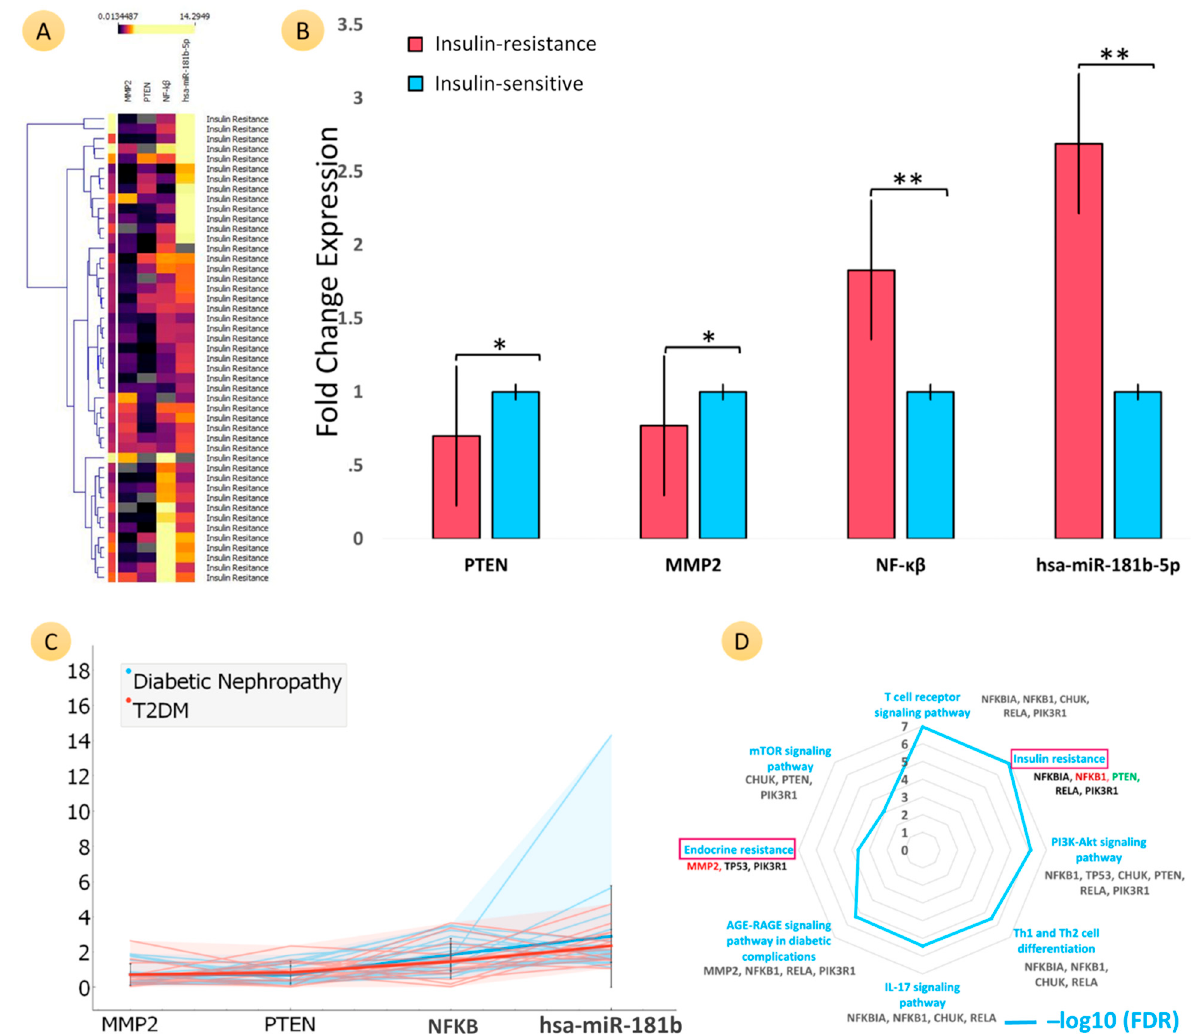
Figure 3. Comparative analyses of the mRNA expression of three genes (PTEN, MMP2, and NF- ĸ B) and microRNA-181b-5p for two groups: insulin-sensitive (IS) (control group) and insulin resistance (IR) (case group). The classification criteria of the samples were based on HOMA-IR values (IS: ≤ 2.5; IR: >2.5). Heat map ( A ) shows the fold change (FC) of genes PTEN, MMP2, and NF- ĸ B and of microRNA-181b-5p for both T2DM and diabetic nephropathy samples of IR patients (fold change expression (FCE) values represent the upper part of heat map with their respective colour densities). ( B ) Bar graphs show the comparative FCs of PTEN (IR FC: 0.70 ± 0.57), MMP2 (IR FC: 0.77 ± 0.69), and NF- ĸ B (IR FC: 1.83 ± 1.02) as well as miR-181b-5p (IR FC: 2.69 ± 2.30) with the control group (IS FC: 1 ± 1.05). PTEN and MMP2 were significantly downregulated for IR patients, and NF- ĸ B and hsa-miR-181b-5p were significantly upregulated. Bar plot colour representation: the insulin resistance group is the coral colour, and the insulin-sensitive group is the blue colour. ** ≤ 0.05; * ≤ 0.001. ( C ) Trend plot shows the complete visualization of FC distribution and the entire trend of all genes and microRNA for the IR groups of both T2DM and DN patients. The FCs of PTEN and MMP2 were more downregulated and NF- ĸ B and hsa-miR-181b-5p were more upregulated in DN patients compared to T2DM without nephropathy for IR patients. ( D ) Radar plot (values: − log10 FDR) represents the significant KEGG pathways in two important pathways, endocrine resistance (MMP2) and IR (PTEN and NF- ĸ B), influenced by our studied genes.